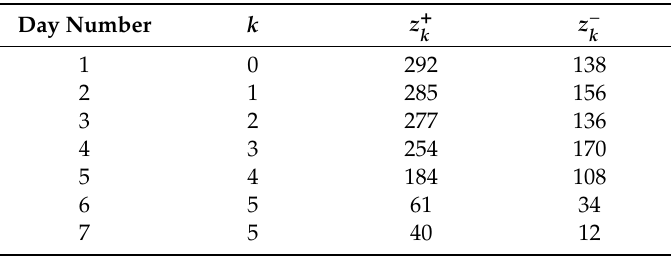
Figure 2. Activity intervals for each day of the week throughout the year. Table 1. Activity interval